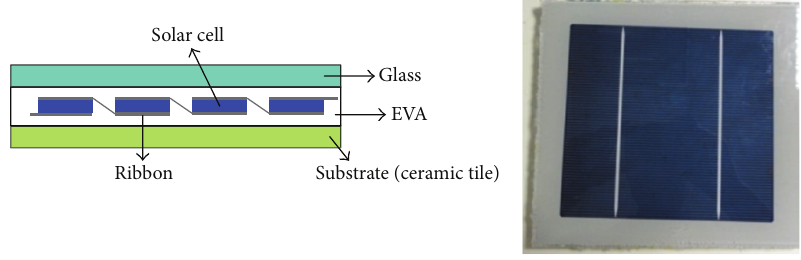
Figure 1: Schematic diagram of the proposed PV